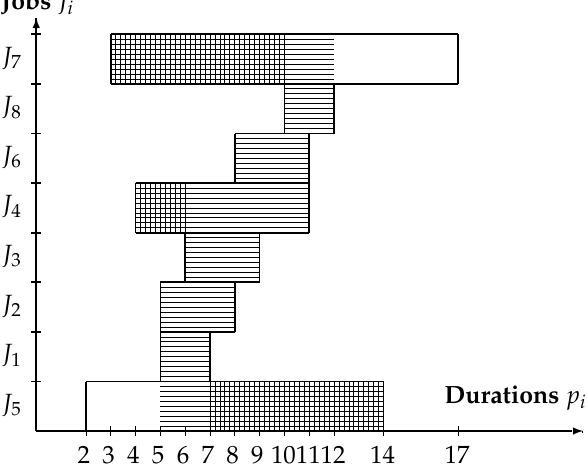
Figure 3. The segments of optimality, non-optimality (double-shaded) and conditional optimality (shaded) for the jobs J i ∈ J in the permutation π 3 = ( J 5 , J 1 , J 2 , J 3 , J 4 , J 6 , J 8 , J 7 ) ∈ S